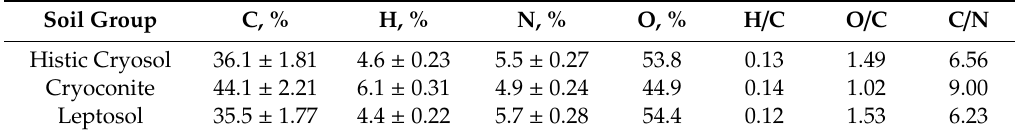
Table 4. Elemental compositions of the studied humic acids with ± SD.